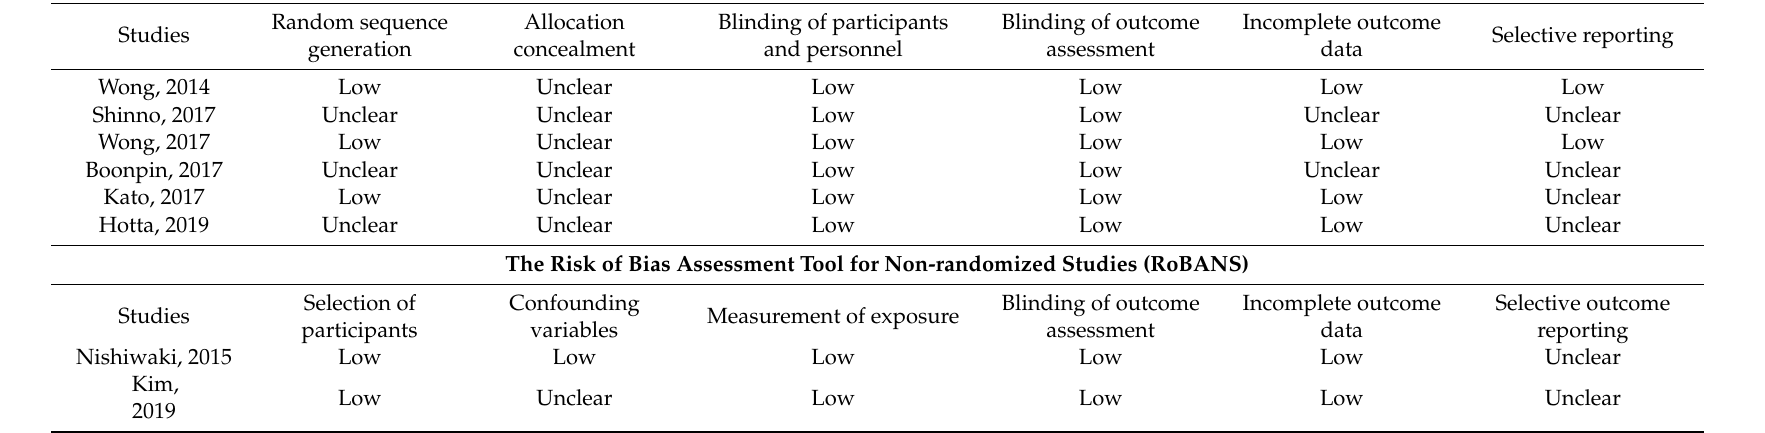
Table 2. Risk of bias. The Cochrane Collaboration: Tool for Randomized